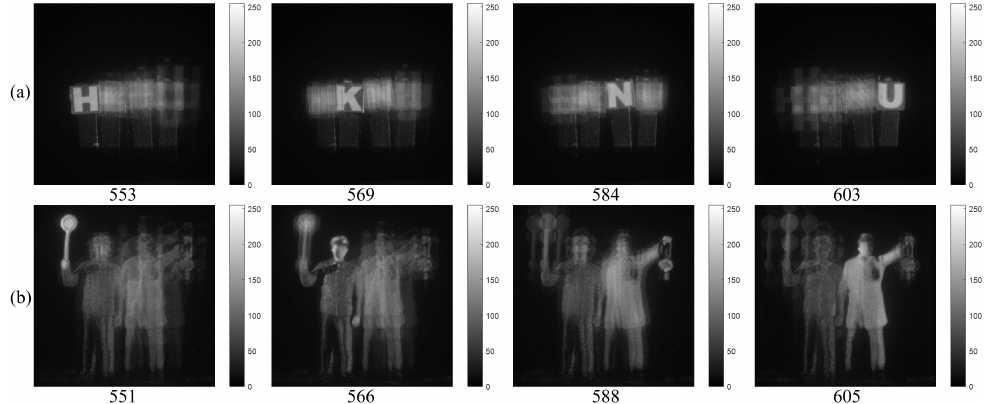
Figure 11. 3D images under normal illumination with various spatial periods at reconstruction depths by the original diffraction images of ( a ) HKNU objects and ( b ) Men objects,